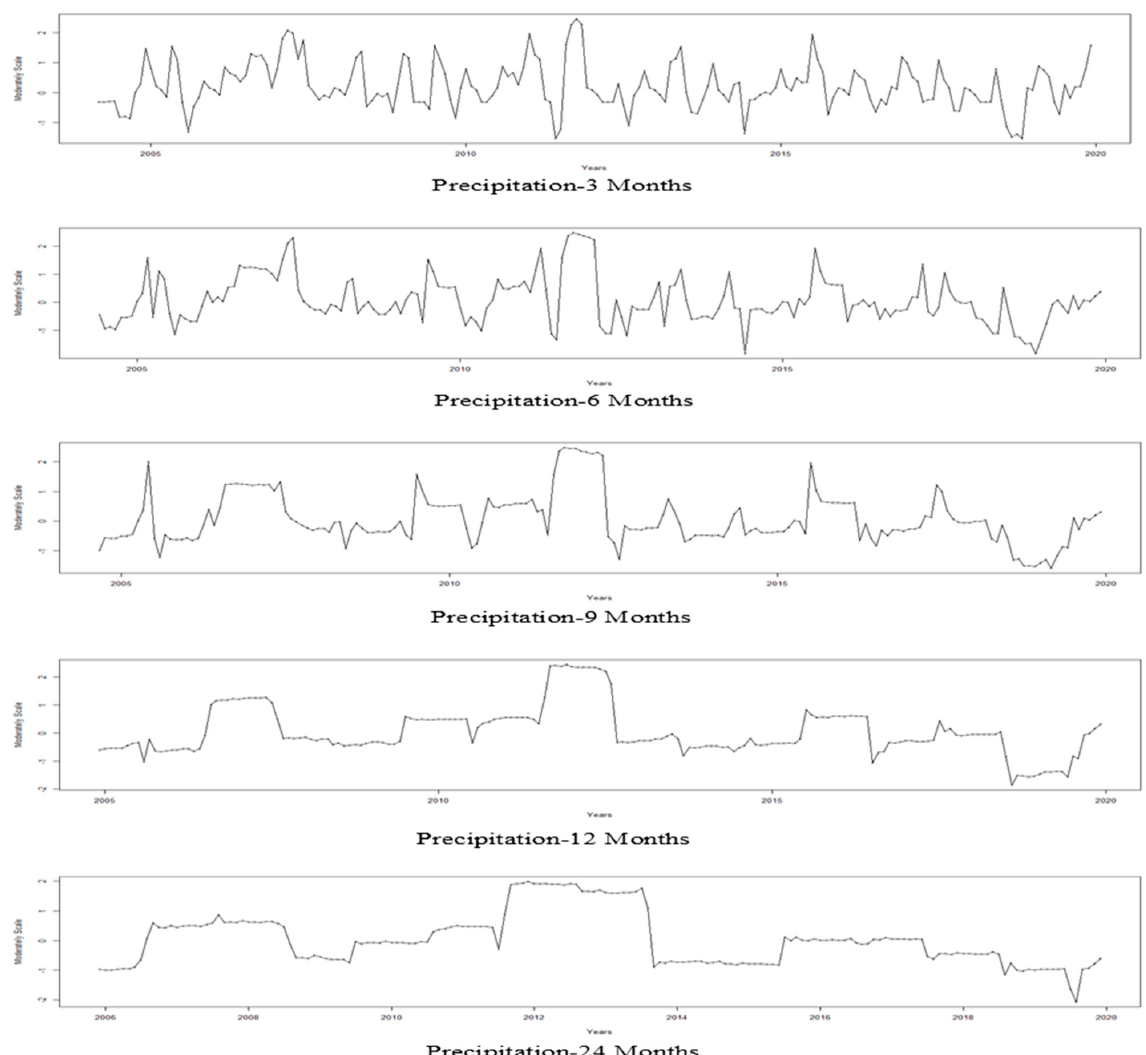
Figure 4. Precipitation and the highest rainfall during the period 2016 to 2019 and the lowest rain fall in the period of 2009 to 2014.